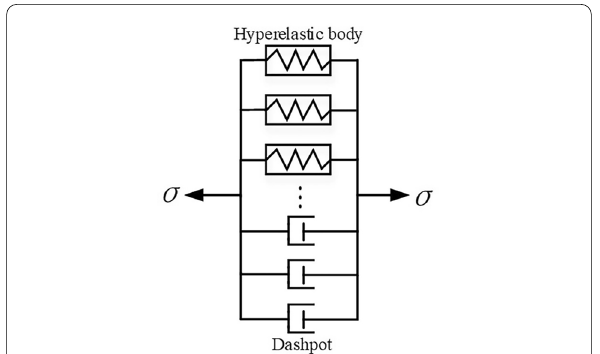
Figure 5 The modified Kelvin-Voigt Model for soft tissue